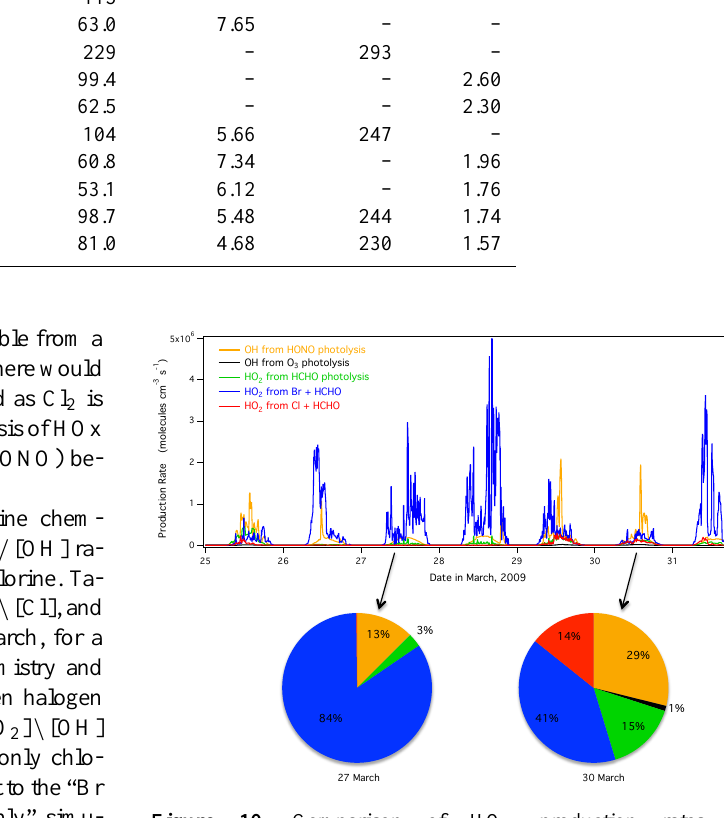
Figure 10. Comparison of HO x production rates (in moleculescm − 3 s − 1 ) for five primary pathways: OH produc- tion from HONO photolysis (orange trace), OH production from O 3 photolysis and subsequent reaction with H 2 O (black trace), HO 2 production from HCHO photolysis (green trace), HO 2 production from Br + HCHO reaction (blue trace), and HO 2 production from Cl + HCHO reaction (red trace). The corresponding pie charts represent the fractional importance of each source for a select ODE day (27 March; O 3 >5ppbv) and a select non-ODE day (30 March) calculated as the median value across each day. Time is expressed in Alaska Standard